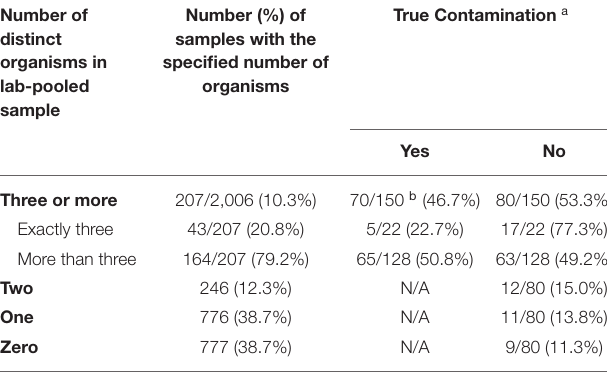
TABLE 3 | Number (%) of samples with contamination and true contamination status, stratified by the number of distinct organisms identified in the lab-pooled